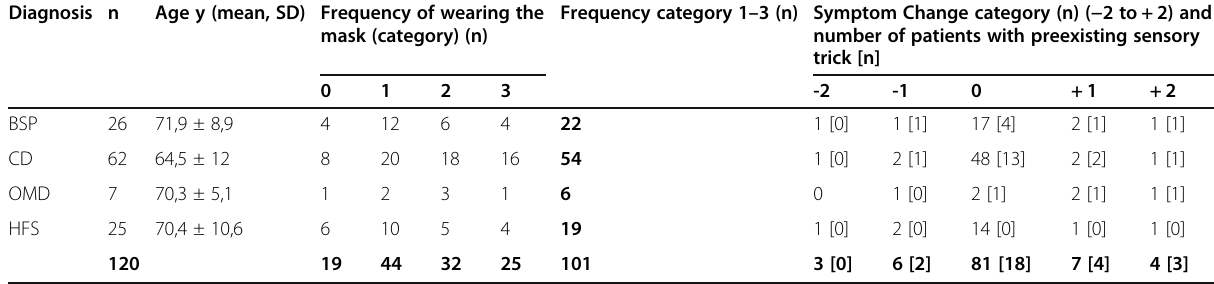
Table 1 Baseline characteristics, mask wearing frequencies, and symptom changes of the evaluated patients during cycle 1 Diagnosis n Age y (mean, SD) Frequency of wearing the mask (category)